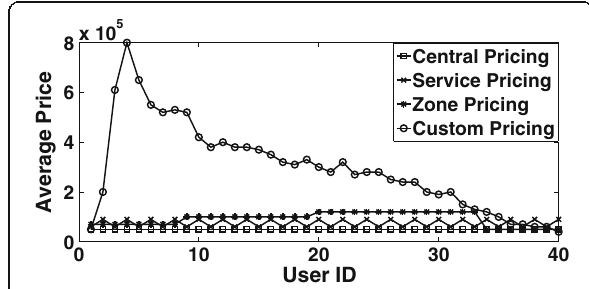
Fig. 5 Average price (dimensionless) versus user ’ s ID considering the alternative implementations of RP